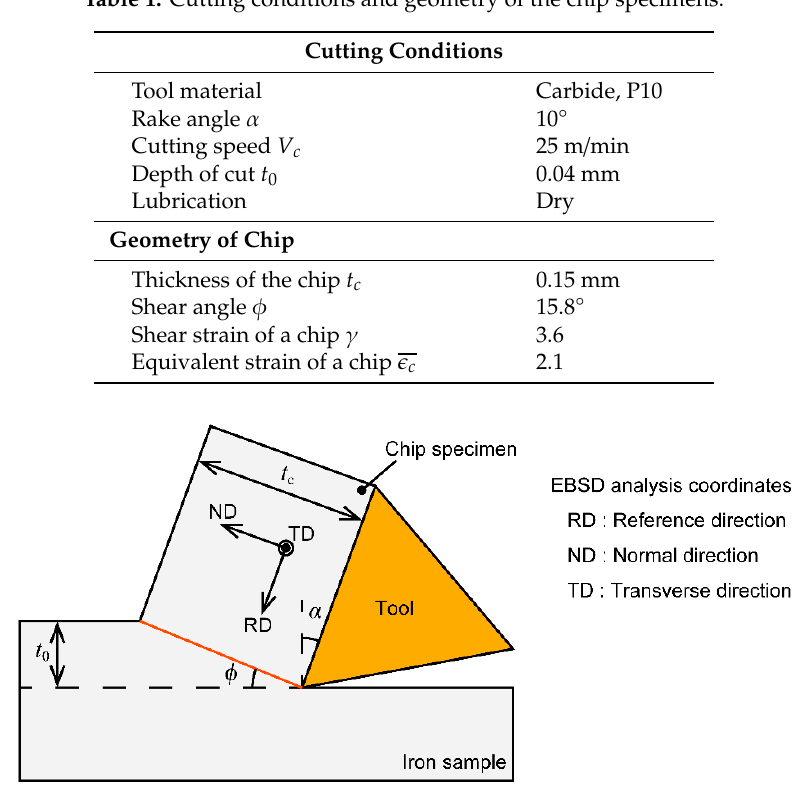
Figure 1. Schematic illustration of an orthogonal cutting model.